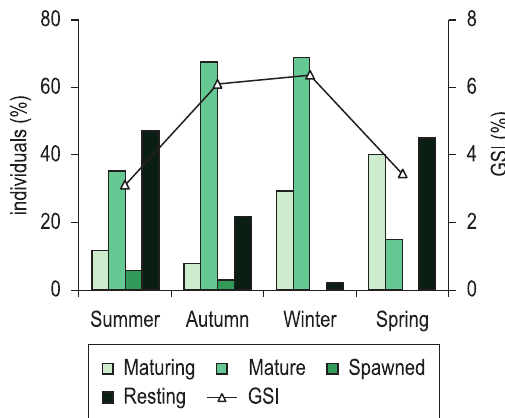
Figure 2. Variations in the gonad somatic index (GSI) of A. fasciatus and gonadal development stage for season